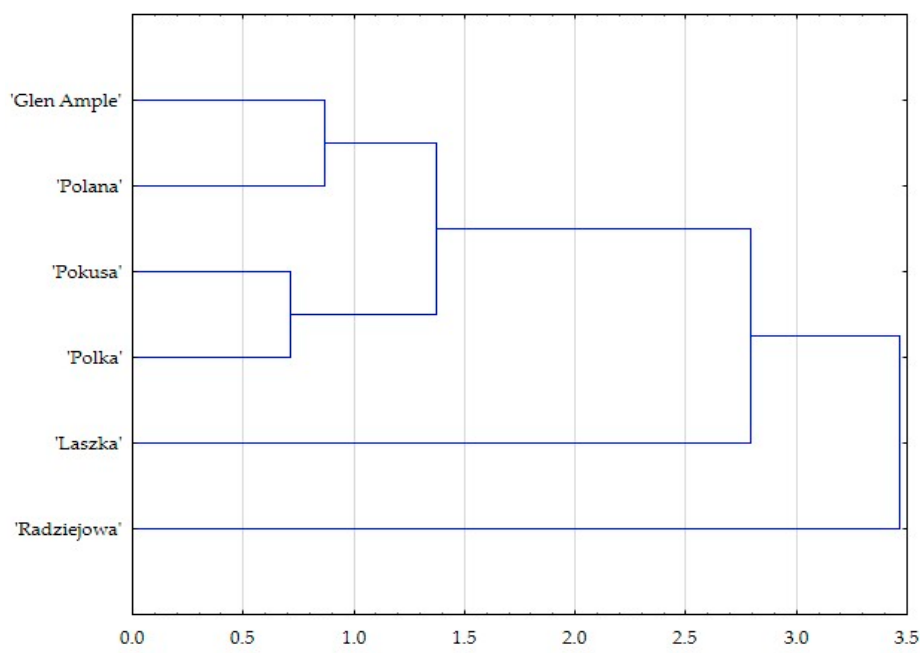
Figure 9. A dendrogram of the hierarchical cluster analysis based on the Euclidean distance measure and Ward’s methods for the analyzed R. idaeus varieties.